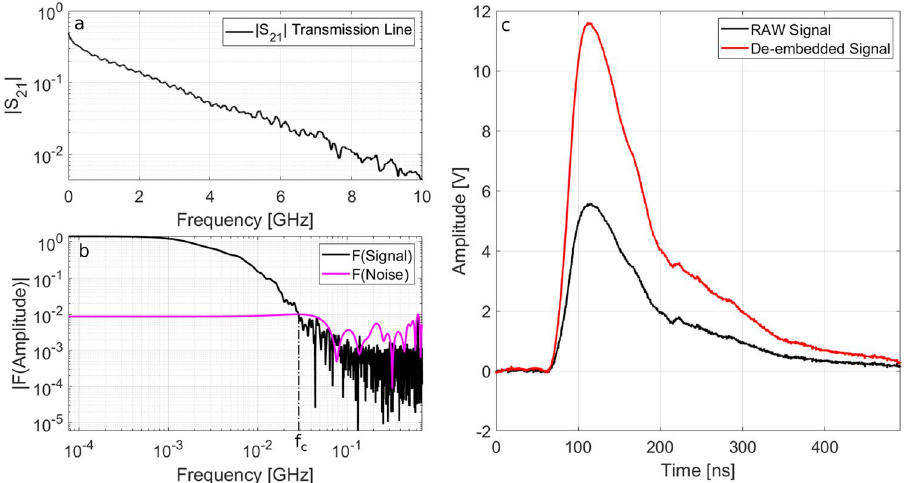
Figure 7. ( a ) The Scattering parameter S 21 of the transmission line (coaxial cables, splitter and bias tee) measured with the Agilent N5230A Network Analyzer ( b ) Fourier transform of the acquired signal and of the background noise ( c ) De-embedded signal S D compared with the original raw V(t), equal to the double of the signal detected on